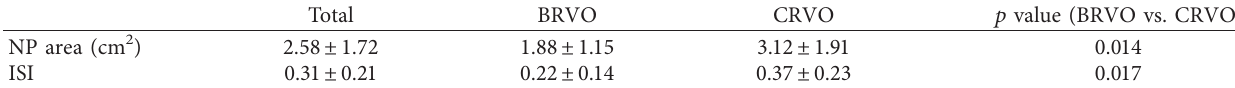
Table 2: NP area and ISI on UWFA of RVO.